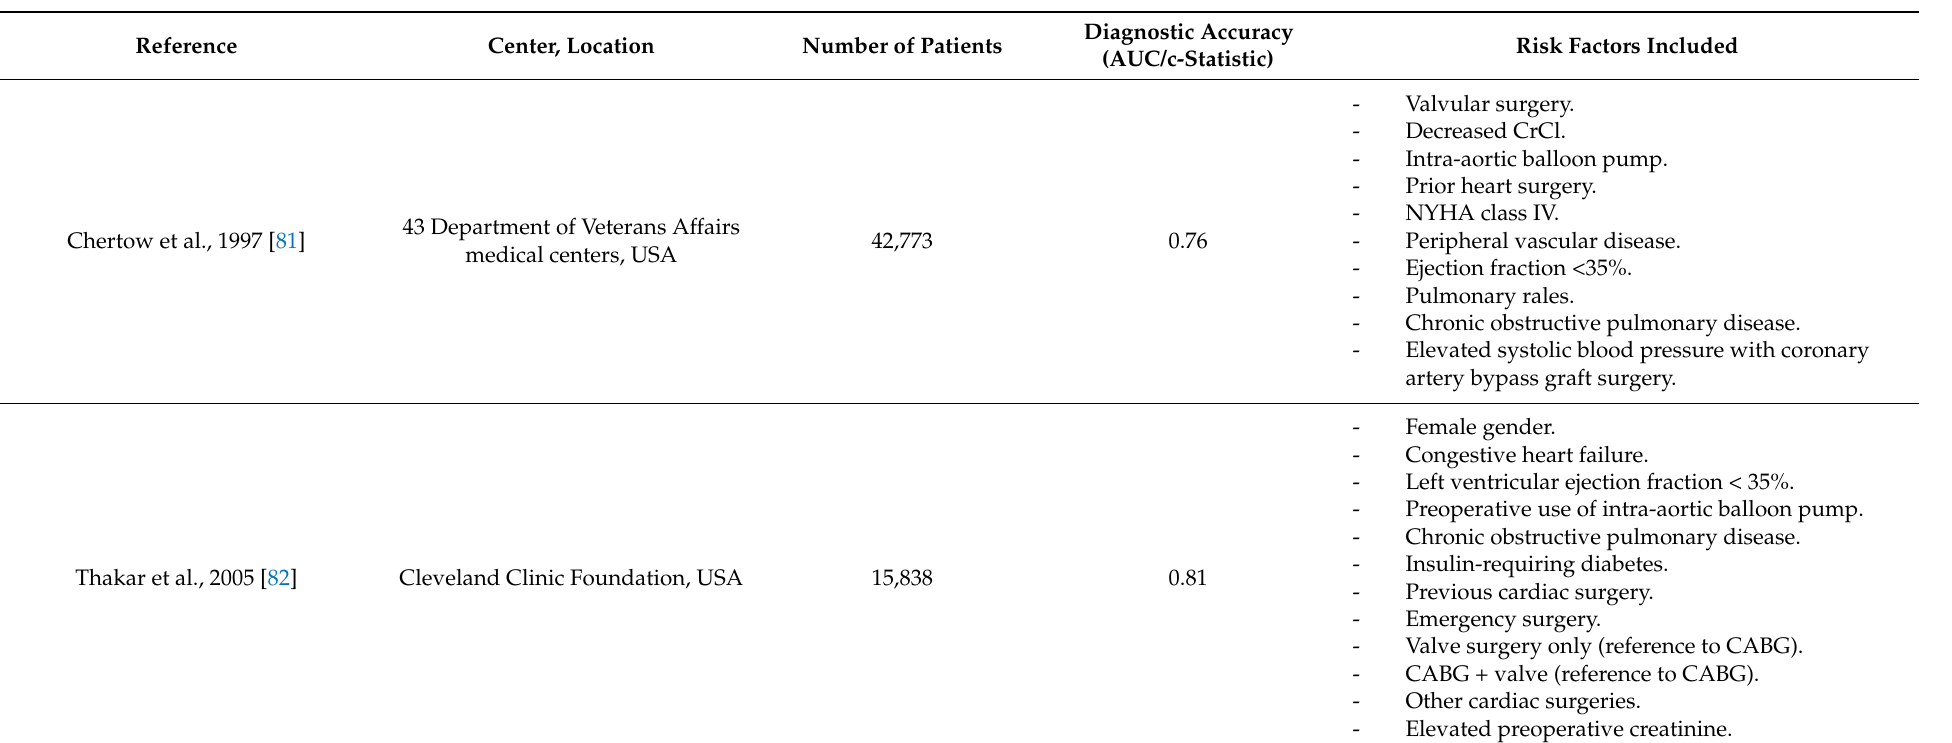
Table 2. Risk scores for the prediction of CSA-AKI based on the algorithmic computation of risk factor. AUC, area under the curve; BMI, body mass index; CABG, coronary artery bypass grafting; CCB, calcium channel blockers; CHD, coronary heart disease; CHF, chronic heart failure; CoHF, congestive heart